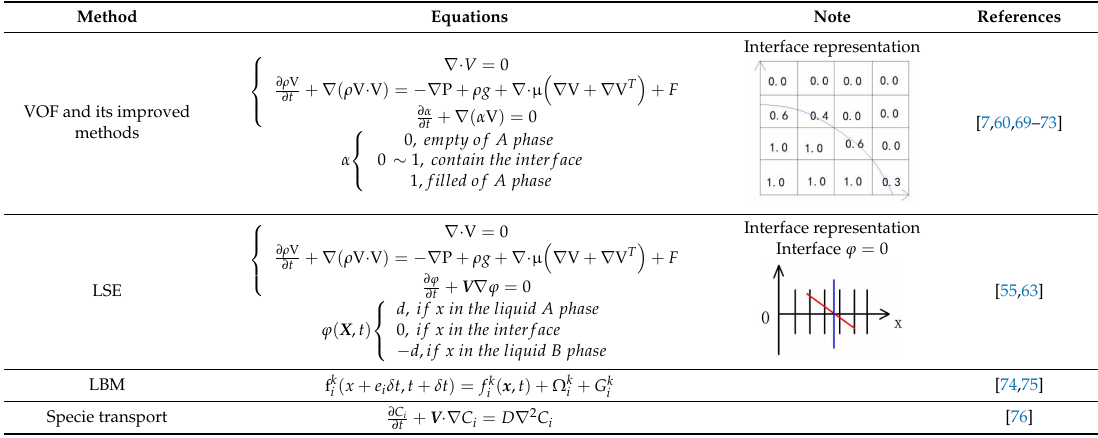
Table 2. The difference of simulation